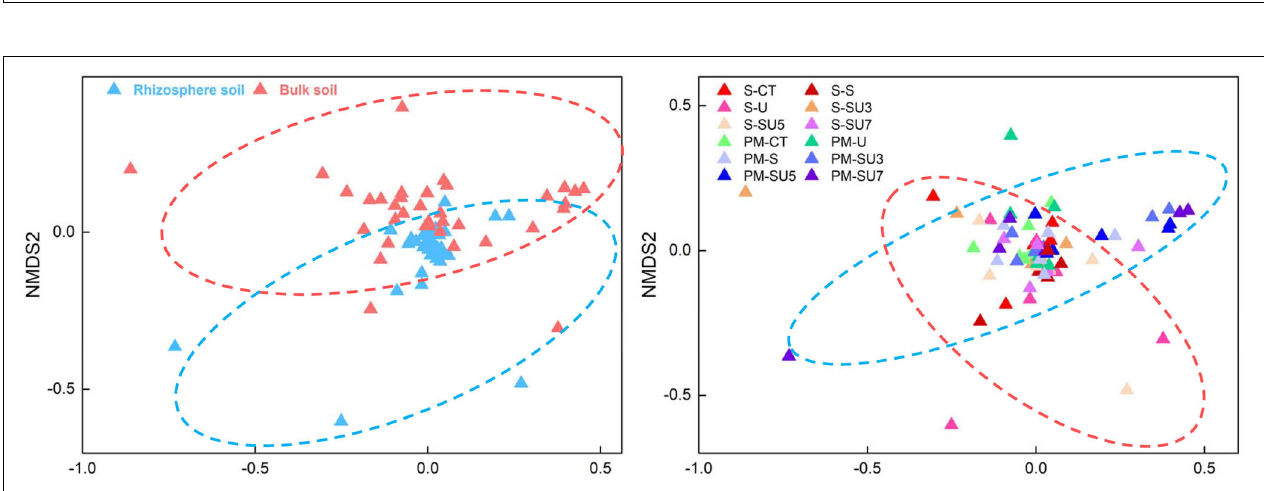
FIGURE 4 | Effect of nitrogen fertilizer treatments (including CT, U, S, SU3, SU5, and SU7) on the NMDS of rhizosphere and bulk soil at different maize growth stages (i.e., silking and physiological maturity).